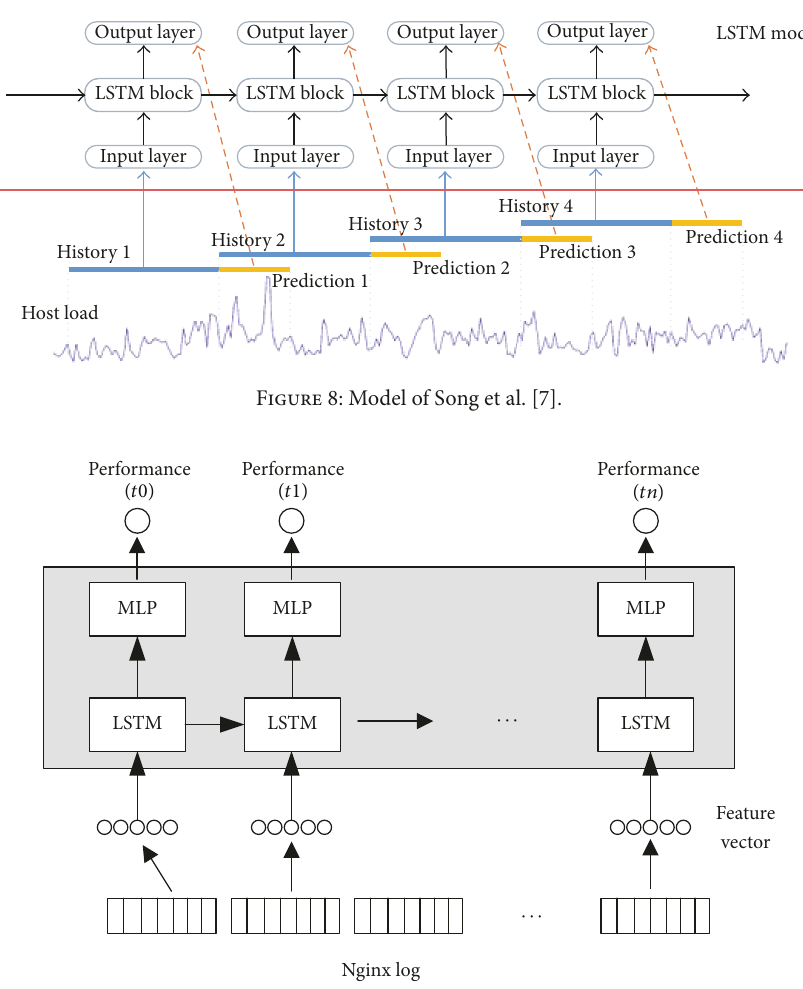
Figure 9: Model of our previous work.